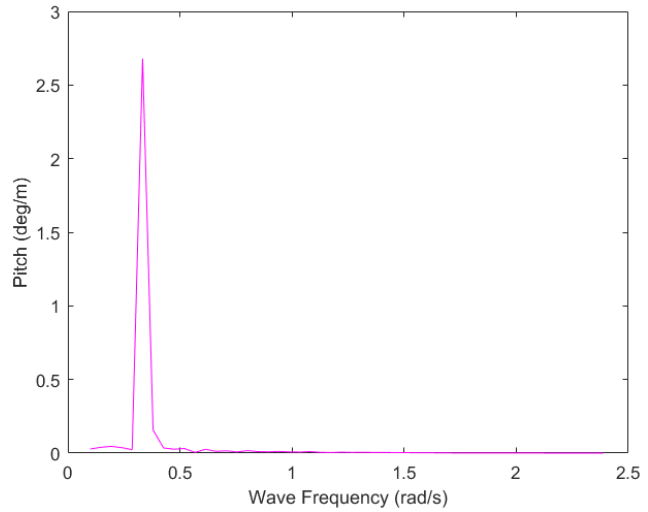
Figure 20. The frequency response of the pitch motion of the platform.